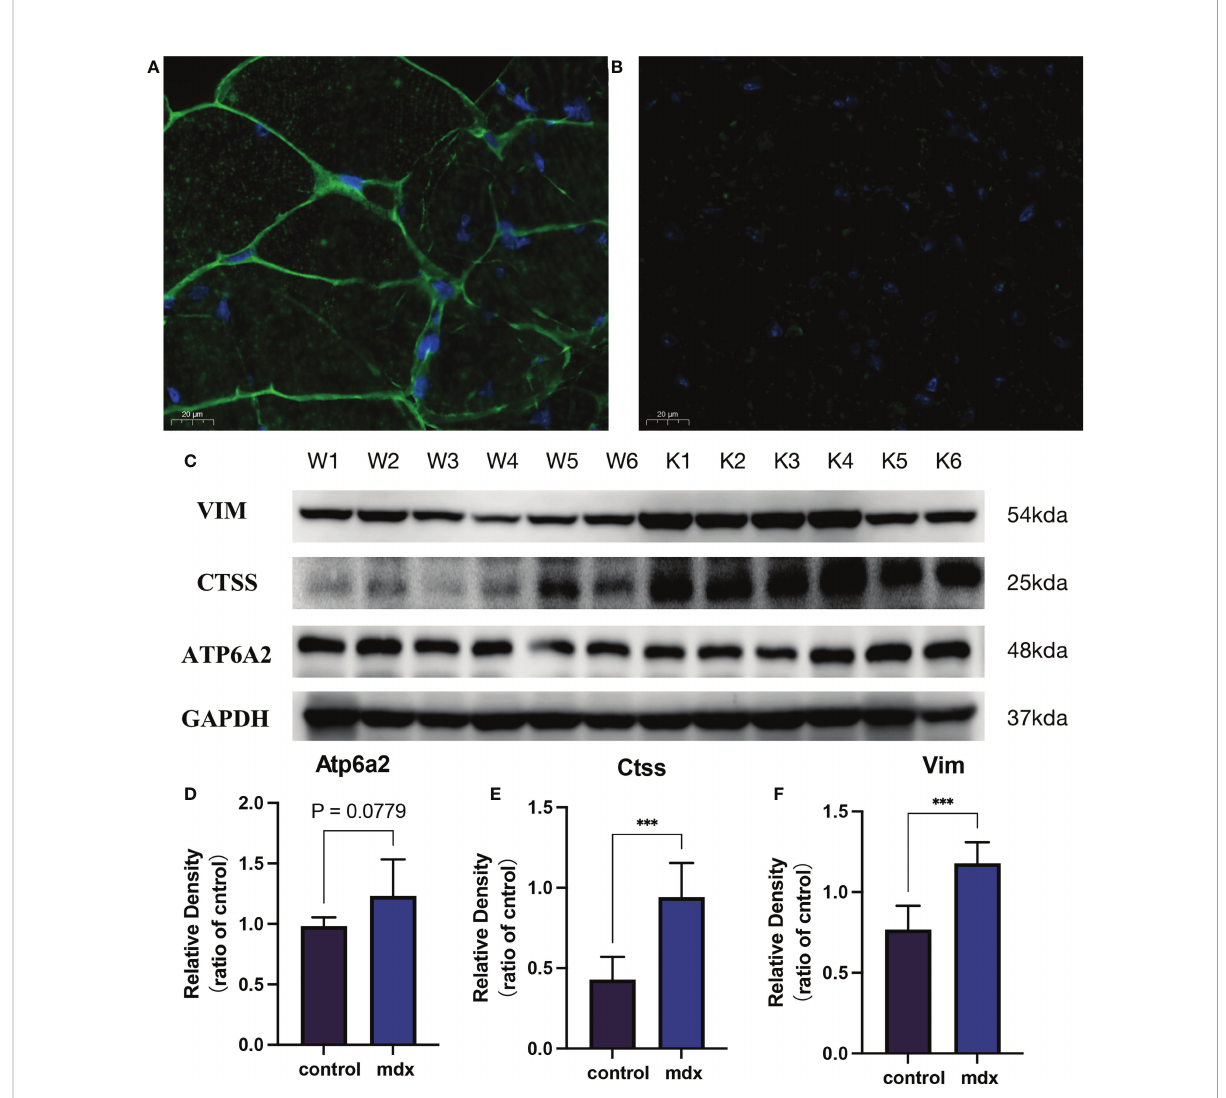
FIGURE 14 The validation of the biomarkers in the DMD model. Representative images of dystrophin immuno fl uorescence on wild type (A) and mdx mice group (B) . (C) Representative western blot results of the 3 biomarkers. (D – F) Relative protein expression levels of the 3 biomarkers (n = 6). ***P < 0.001, mdx vs. the control